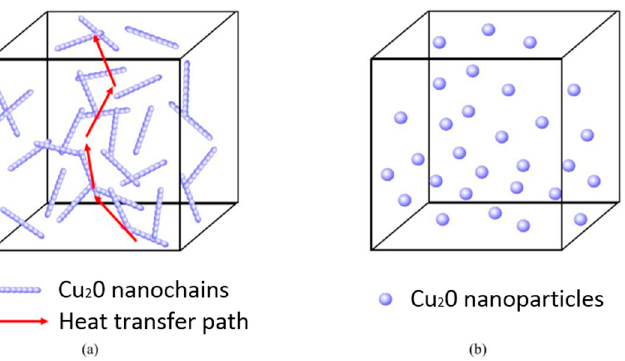
Figure 1. Schematics diagram of the heat transfer process of ( a ) Cu 2 O nanochains and ( b ) Cu 2 O nanoparticles in the nanofluids. nanoparticles in the